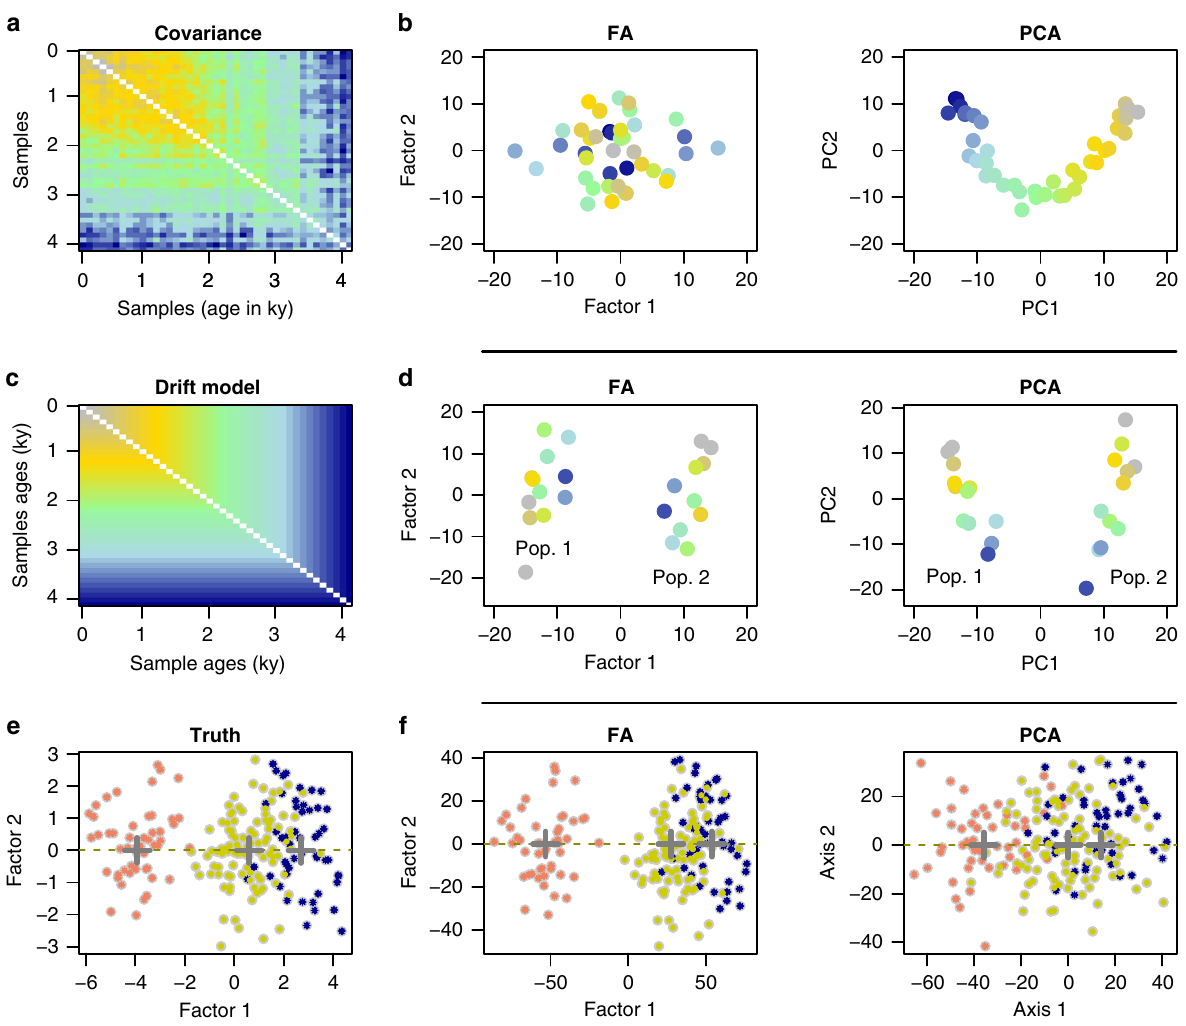
Fig. 1 Correcting arch and shrinkage effects. a – c Coalescent simulation of allele frequencies drifting through time in a random mating population. Samples with ages ranging from 0 (present-day) to 4000 years (past) were simulated. a Covariance matrix for observed samples. In covariance matrices ( a – c ), blue colors indicate lower covariance values whereas the yellow and gray colors indicate higher values. b FA and PC plots of individual samples (present- day: gray color, past: dark blue color). c Theoretical covariance matrix de fi ned as the minimum of forward times for pairs of samples (Brownian model). d FA and PC plots for a coalescent simulation of a two-population model (left: population 1, right: population 2, present-day: gray color, past: dark blue color). e – f Factor analysis corrects for a shrinkage effect visible in projections of ancient samples (salmon and blue colors) onto PCs of present-day admixed individuals (yellow color). Gray crosses represent population centers from which admixture estimates